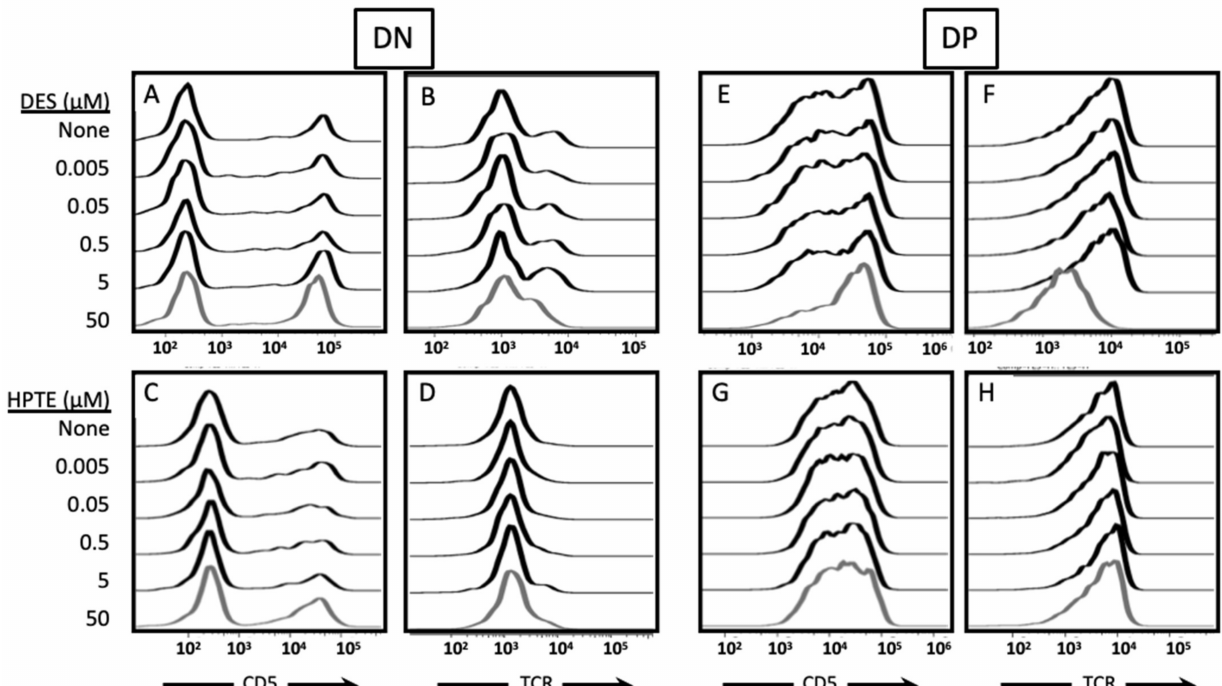
Figure 5. Embryonic thymocytes that survive transient exposure to DES or HPTE after exposure to differentiation signals have altered levels of TCR and CD5 on their surface. Cells were incubated in a two-day differentiation culture, with anti-CD2 and anti-TCR antibodies on day one. For recovery exposure, toxicants at concentrations indicated (0.005, 0.05, 0.5, 5, 50 µ M) were added on day two after cells were washed and transferred to plates without the antibodies. Cells were stained at the end of the two-day incubation period with fluorochrome-conjugated antibodies against CD4, CD8, TCR, and CD5. Shown above are representative histograms from gated DN ( A – D ) or DP ( E – H ) embryonic thymocytes treated with the indicated concentrations of DES ( A , B , E , F ) or HPTE ( C , D , G , H ). Panels on the left are CD5 ( A , C , E , G ). Panels on the right are TCR ( B , D , F , H ). Recovery, DES N = 13, HPTE N =